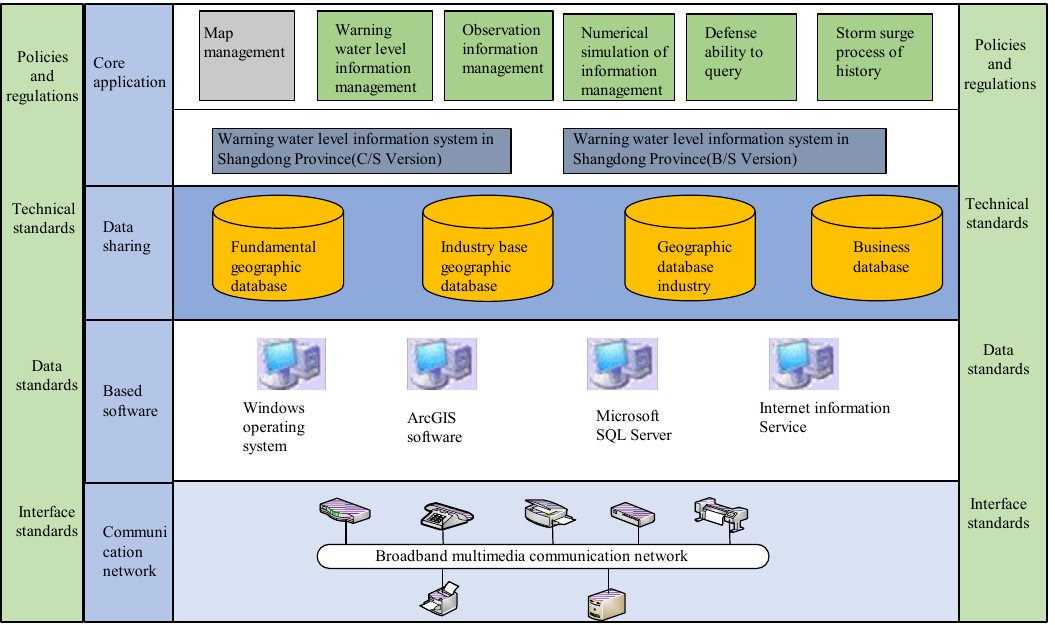
Figure 1. The architecture of the system